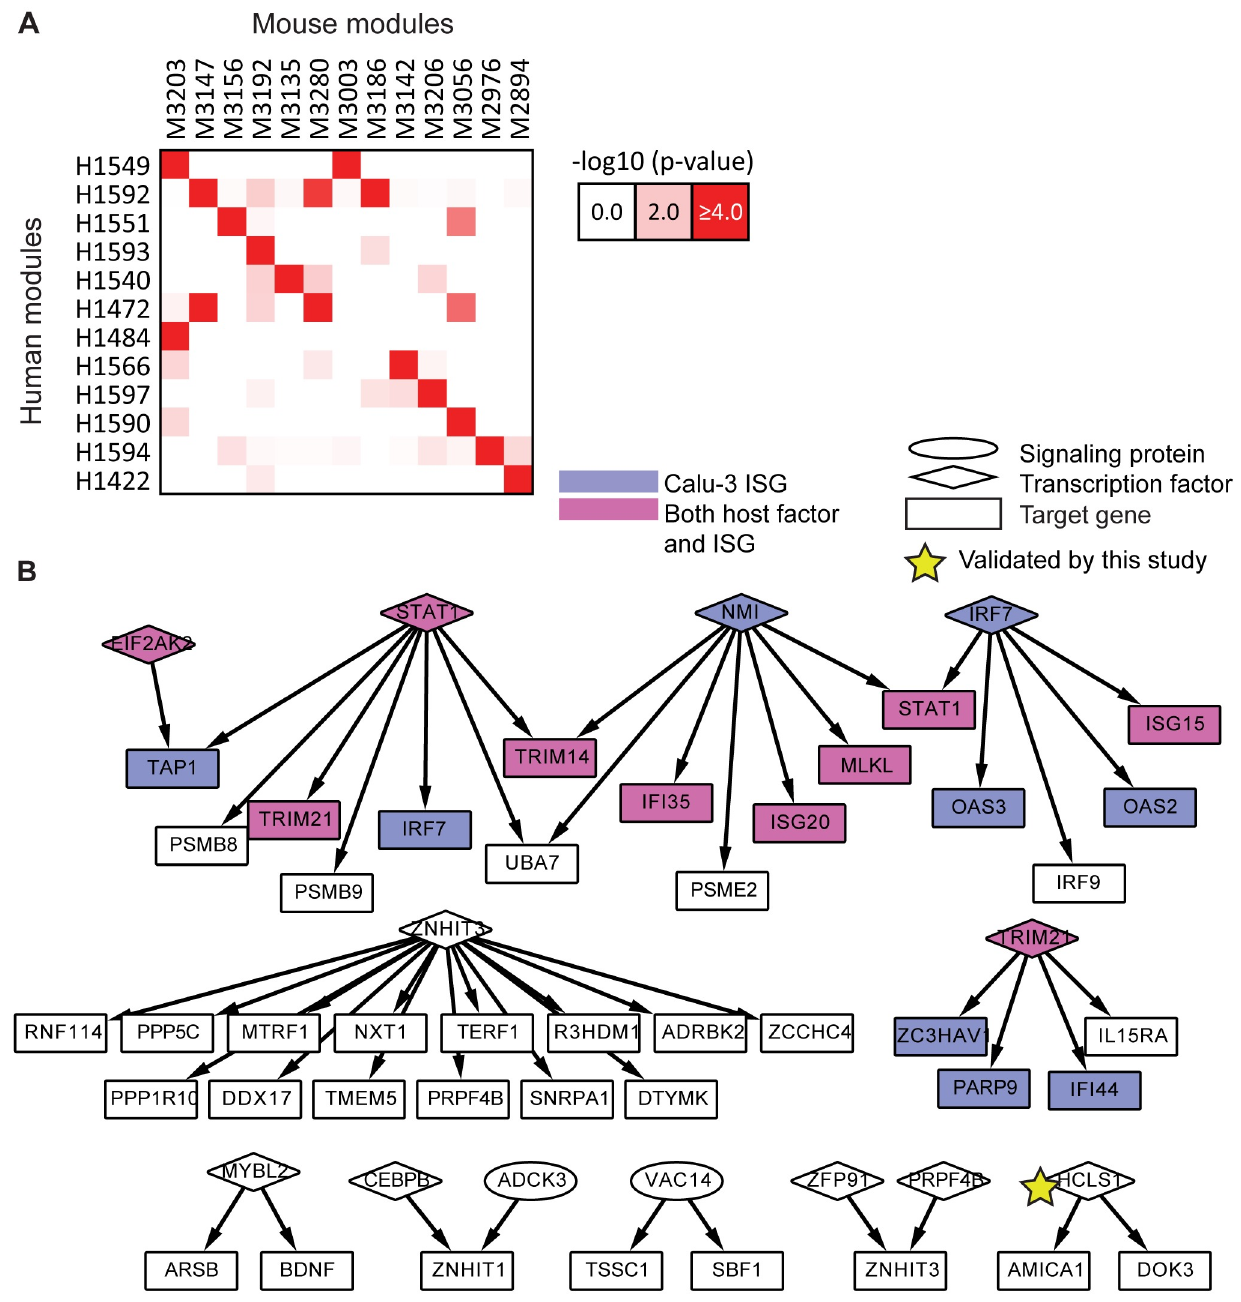
Fig 4. Conservation between human and mouse subnetworks. A. Modules conserved between human and mouse. There were fifteen (red shading) significantly overlapping module pairs (hypergeometric p-value < 0.0001), including 12 human modules and 13 mouse modules. B. A core set of interactions conserved between the human and mouse consensus regulatory networks. Shown are the 48 of 96 shared interactions that belong to subnetworks with at least three nodes. Shading indicates Calu-3 ISGs (violet) and nodes identified both as known host genes and ISGs (magenta). Star indicates a gene that significantly impacted viral replication on knockdown as identified in this study.